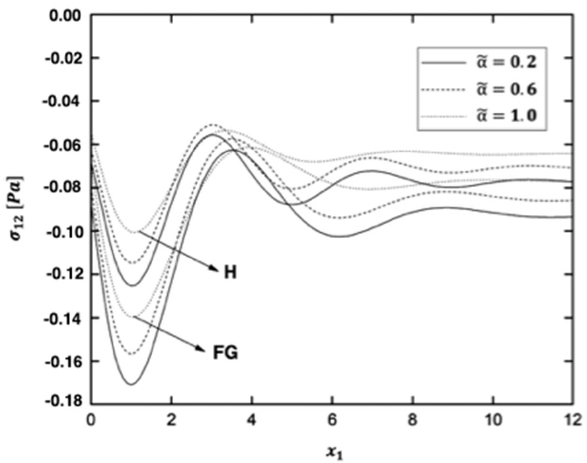
Figure 3. Variation of the thermal stress wave σ 12 along x 1 –axis in the functionally graded (FG) and homogeneous (H) anisotropic fiber-reinforced plates under different fractional order parame- ters.